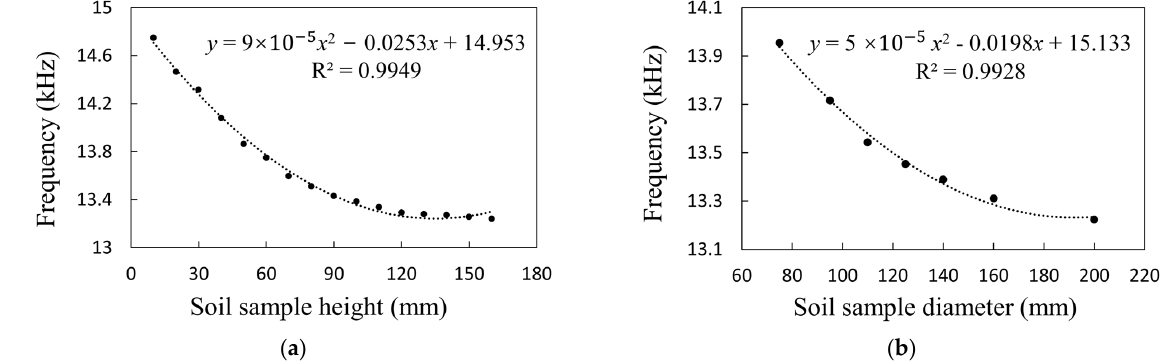
Figure 19. Relationship curve between output signal frequency and soil sample diameter and height.